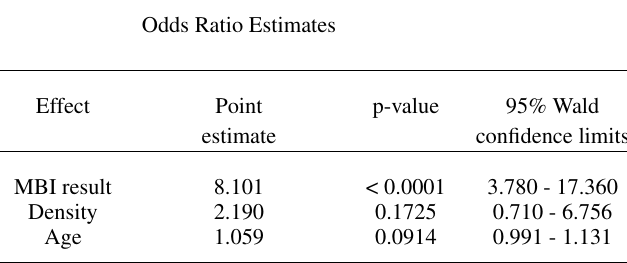
Table 3. Logistic regression of factors relating to breast cancer diagnosis and receiver operator characteristic analysis with